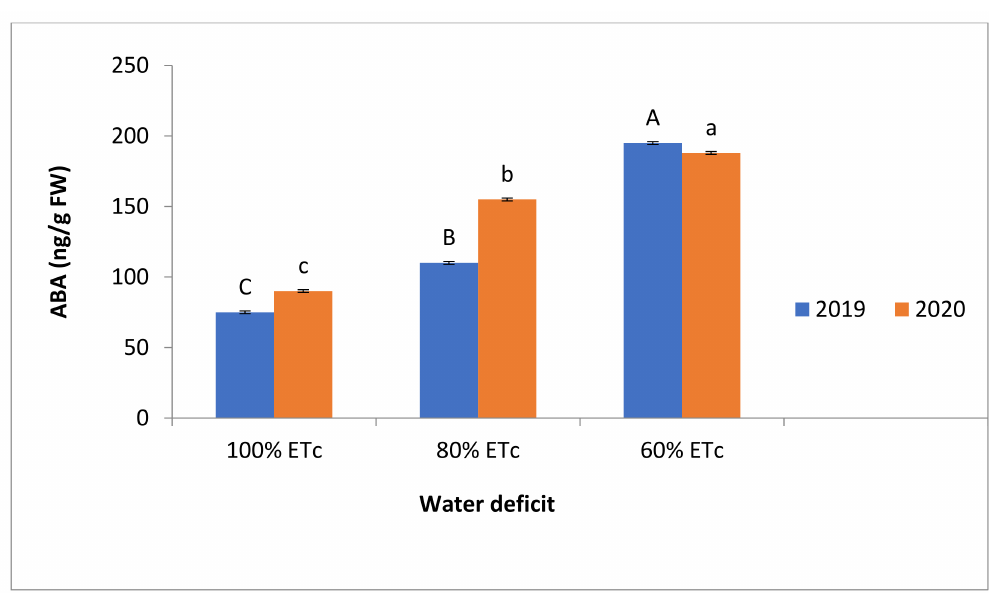
Figure 4. Effect of deficit irrigation (as a percentage of crop evapotranspiration, ETc) on ABA content of ‘African Rose’ plum fruit during the 2019 and 2020 seasons. Standard error bars and DMRT were used for mean comparisons within the same year ( n = 10). Capital and small letters represent DMRT for 2019 and 2020, respectively.